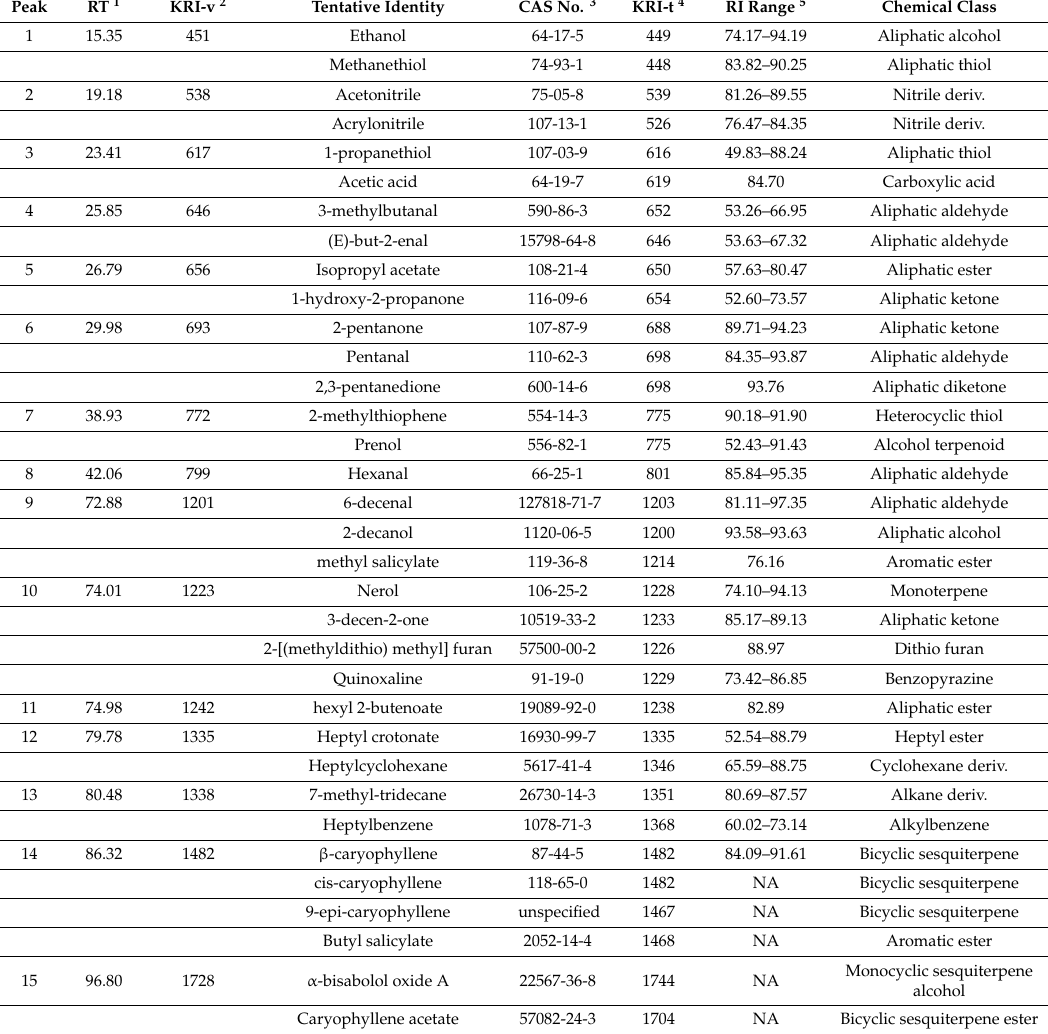
Table 6. Gas chromatographic data indicating tentative identities of healthy host and induced EAB-decline associated response VOC-metabolite emissions from sapwood of green